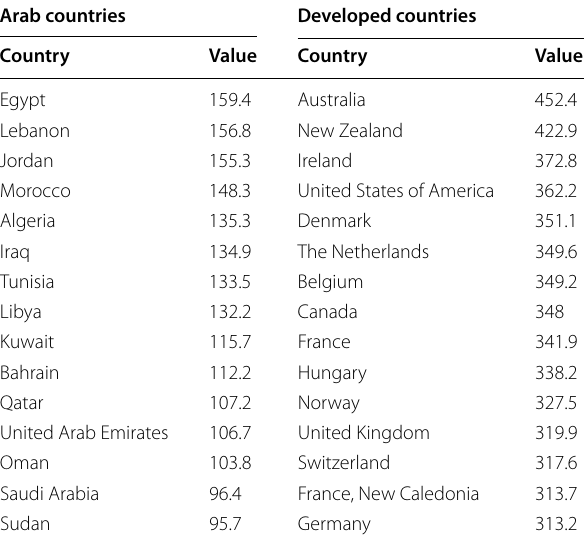
Table 1 Estimated age-standardized incidence rates (World) in 2020, all cancers, both sexes, all